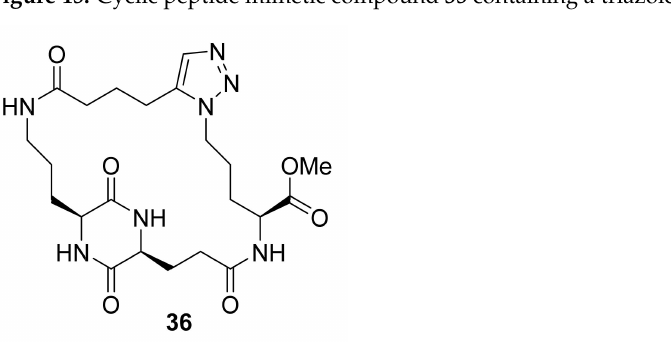
Figure 15. Cyclic peptide mimetic compound 35 containing a triazole.